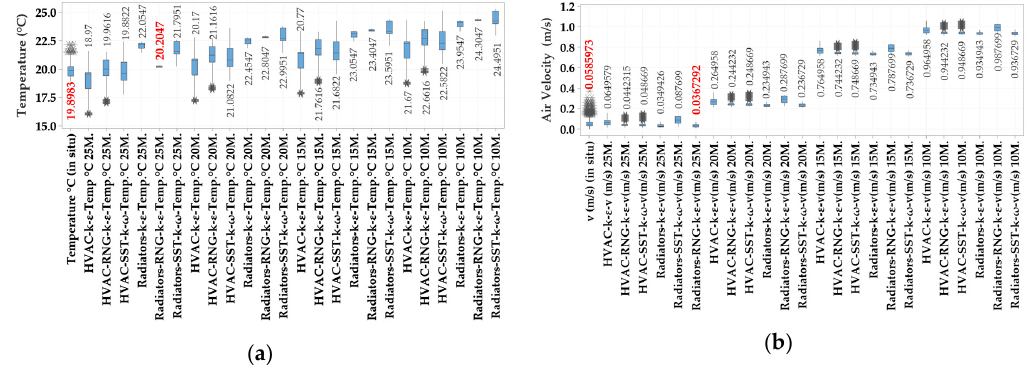
Figure 3. Results for mesh dependents ( a ) temperature and ( b ) air velocities from indoor air quality sensors, static heaters and heating, ventilation and air conditioning (HVAC) system, for the three turbulence models (standard k- ε , SST-k- ω and RNG-k- ε ) and four cases of discretization (10, 15, 20, 25 M).